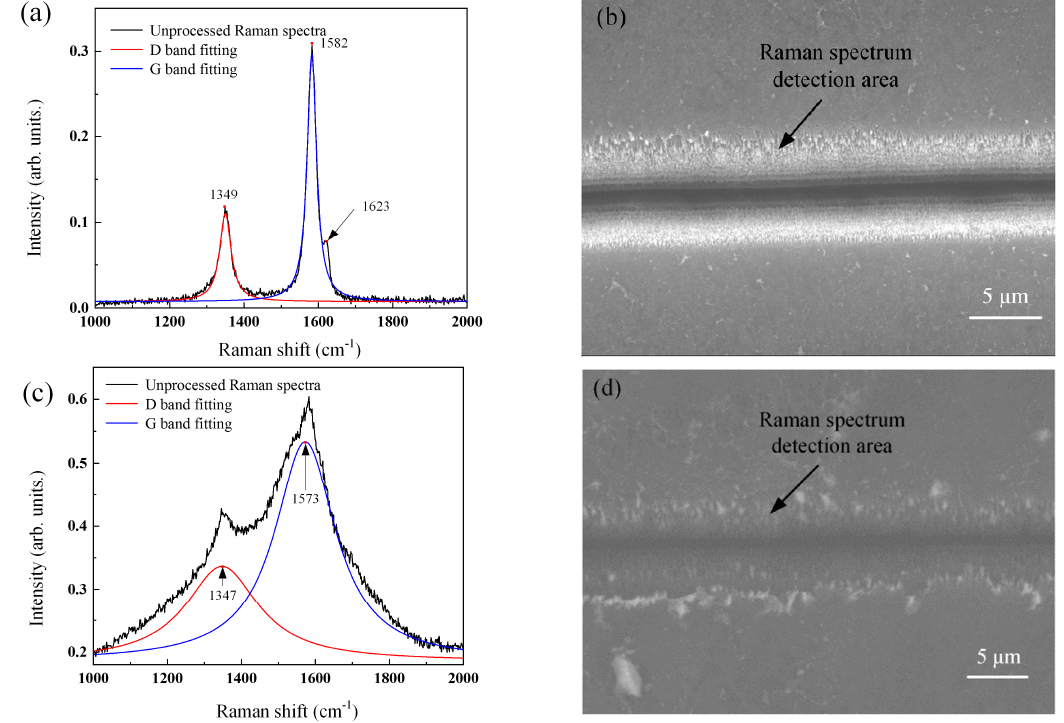
Figure 7. Raman detection and SEM image of the groove entrance of CNT film by laser cutting at different wavelengths under a low pulse energy. ( a , b ) λ = 515 nm; ( c , d ) λ = 1030 nm.